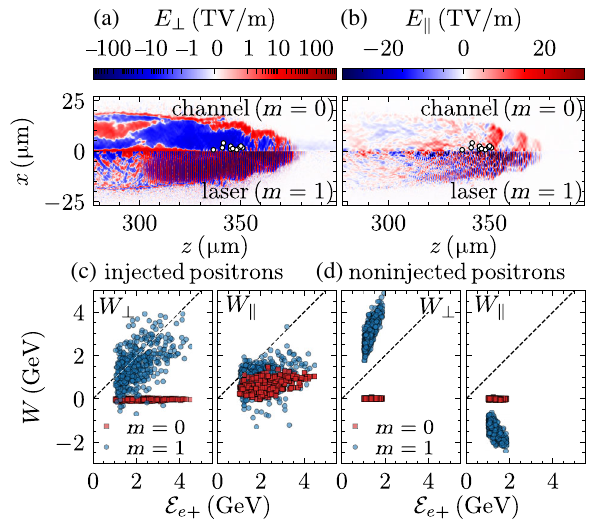
FIG. 3. Positron direct laser acceleration. (a) Transverse electric field ( x direction). White circles represent a sample of injected positrons. Mode m ¼ 1 is associated with the laser component, while m ¼ 0 represents the channel field. (b) Longitudinal electric field ( z direction). (c) Energy gain of injected positrons in transverse ( W ⊥ ) and longitudinal directions ( W k ). (d) Energy gain of noninjected positrons. The energy gains W represent the accumulated work in the channel fields ( m ¼ 0 , red squares) and the laser fields ( m ¼ 1 , blue circles) after a propagation distance of 340 μ